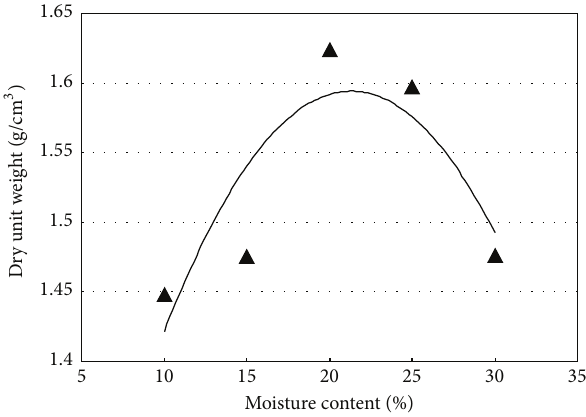
Figure 5: Compaction curve of soil group